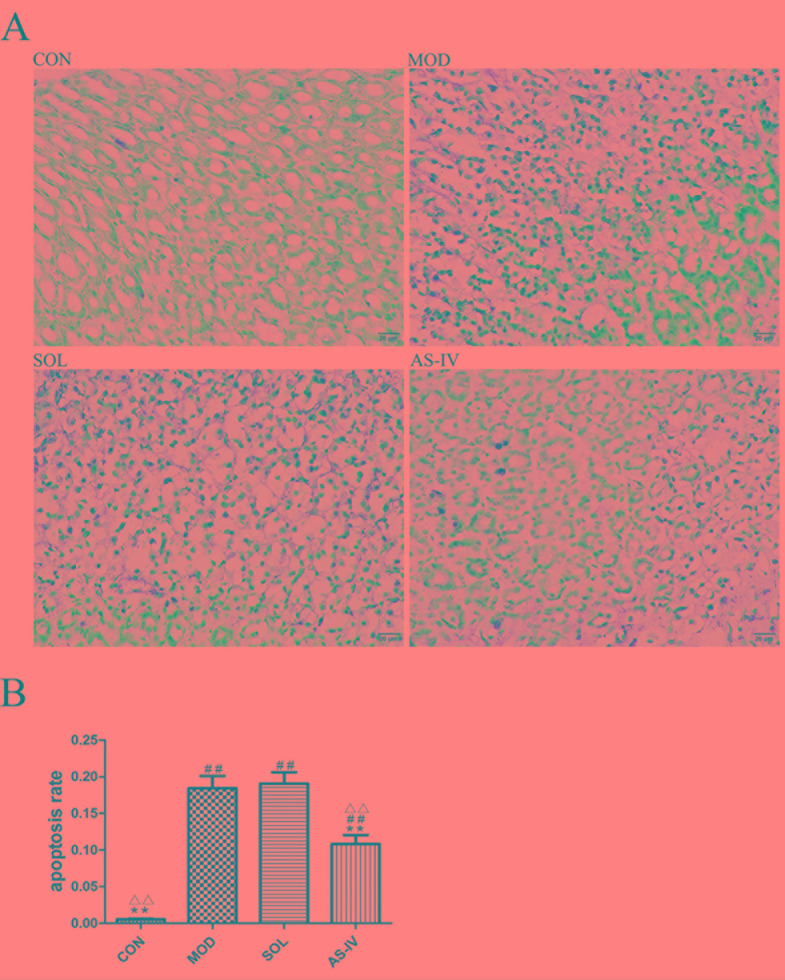
TUNLE assay of gastric mucosa tissue observed under a light microscope (400×). (A) Pretreatment with AS-IV reduced the dark brown staining, which is sign of apoptosis induced by ethanol; (B) The analysis of apoptosis rate. Significant difference (**P < 0.01) when compared with the model group. Significant difference (##P < 0.01) when compared with the control group. Significant difference (∆∆P < 0.01) when compared with the solvent group.